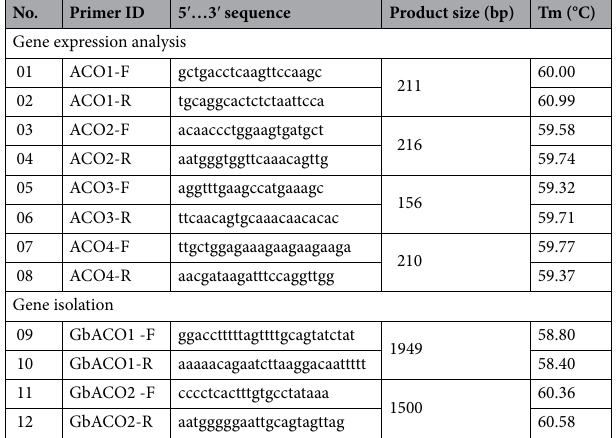
Table 2. Primer sequences used in this